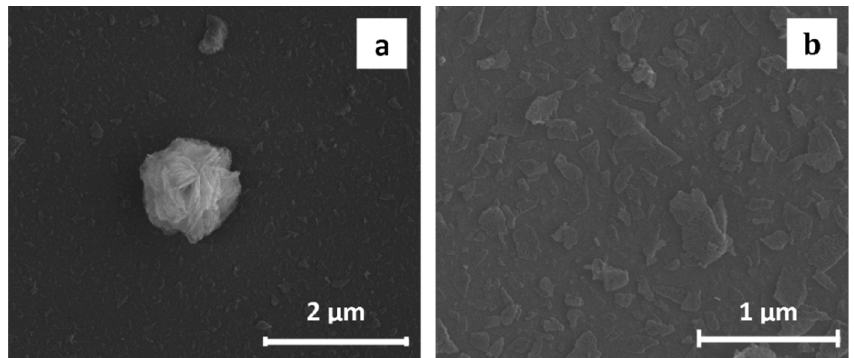
Figure 12. SEM images of ZnO thin film deposited by dip-coating (concentration: 0.3% (w/v); speed: 20 mm/min; reps: 60) and calcinated at 600 °C for 1 h: ( a ) residual ball-like particle, ( b ) uniform layer.